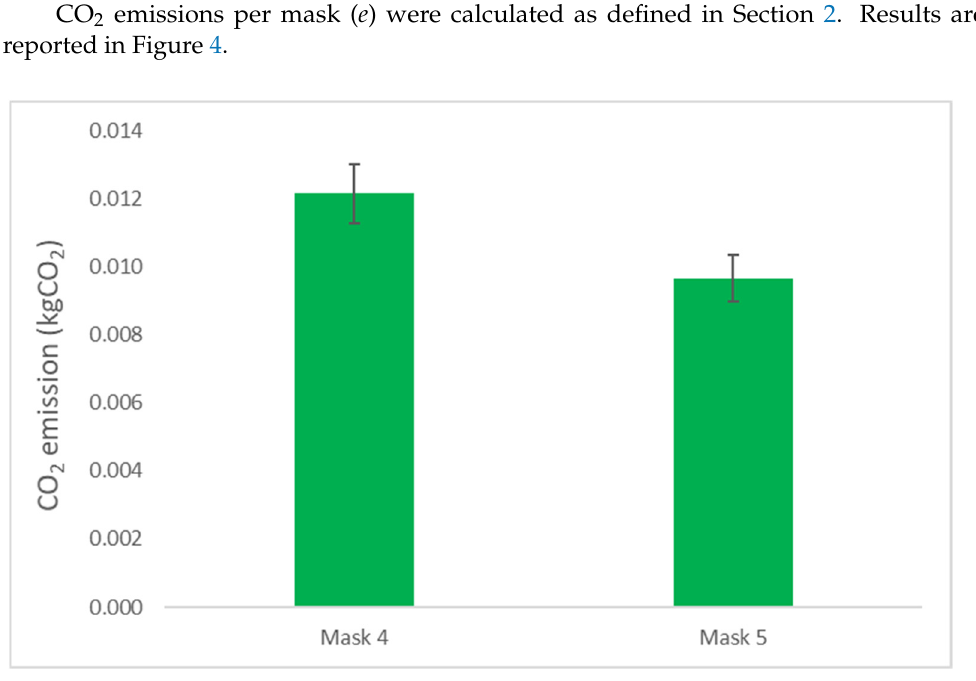
Figure 4. Total average CO 2 emission for each fabric mask expressed in kgCO 2 . Error bars represent minimum and maximum values.